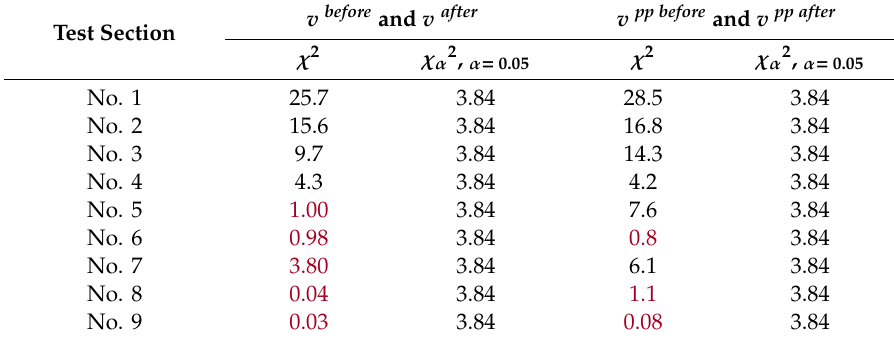
Table A4. Results of test of independence on test sections (free speed v and vehicle flow speed v pp ).